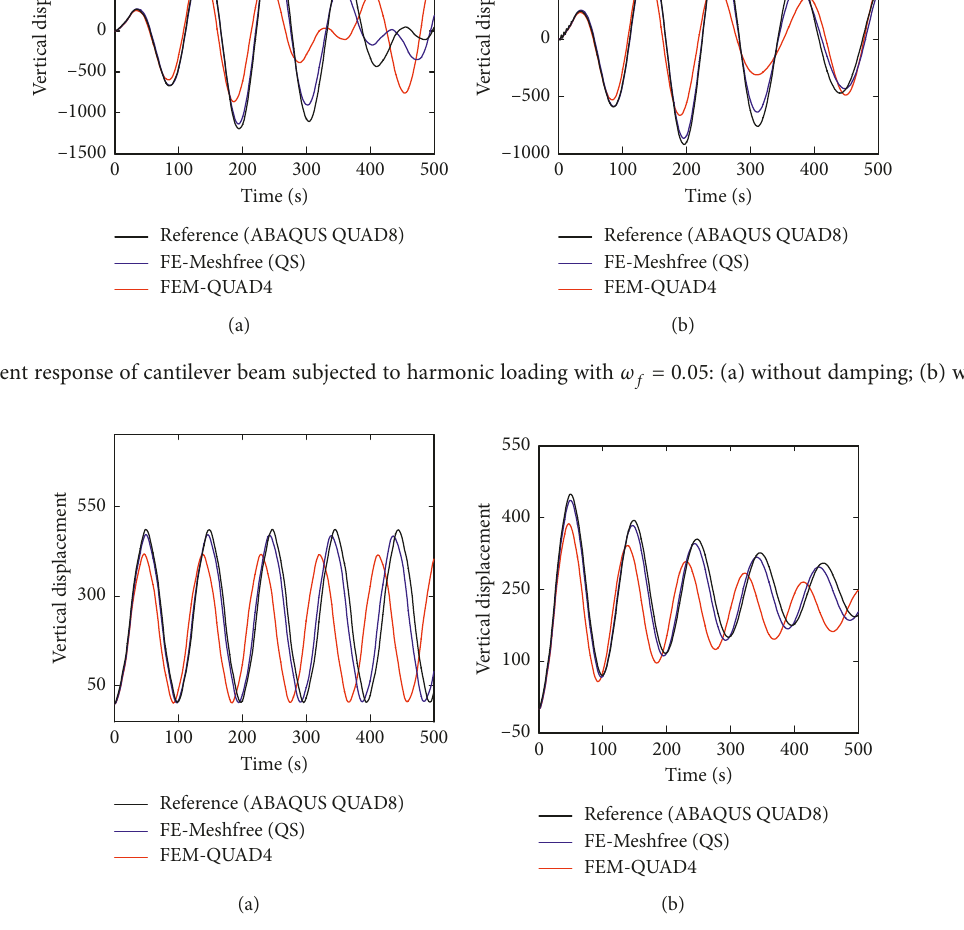
Figure 28: Transient response of cantilever beam subjected to constant step loading: (a) without damping; (b) with